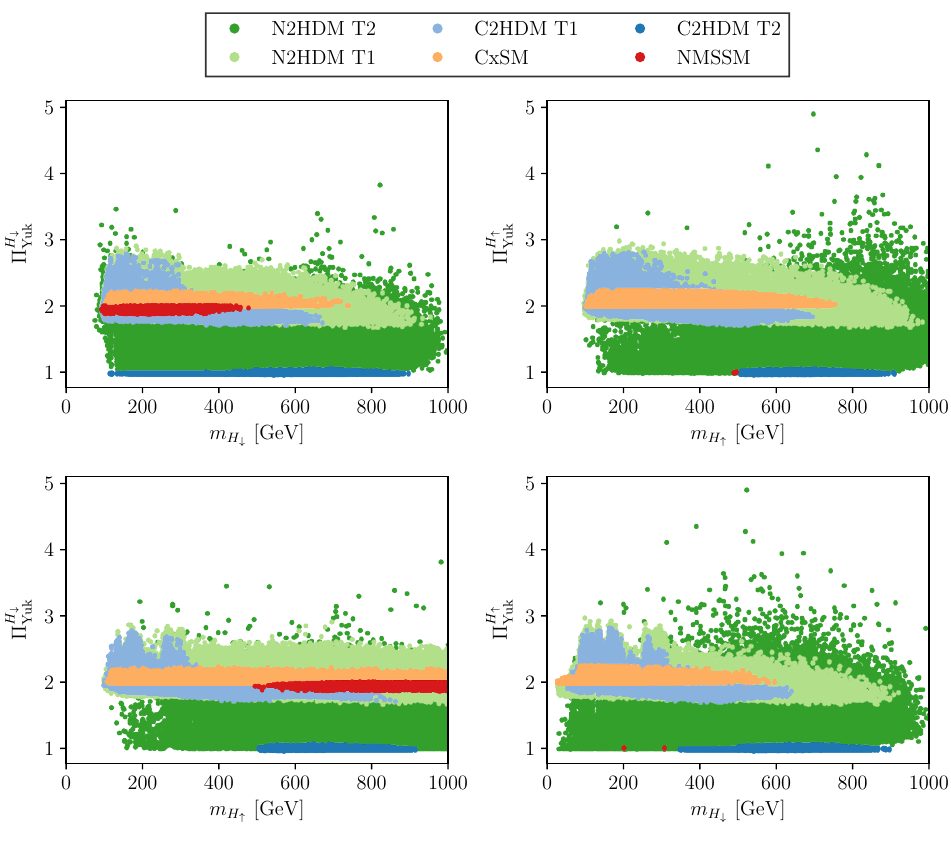
Figure 14 . Same as (cid:12)gure 12 but for the partial Yukawa sum (cid:5) (2)